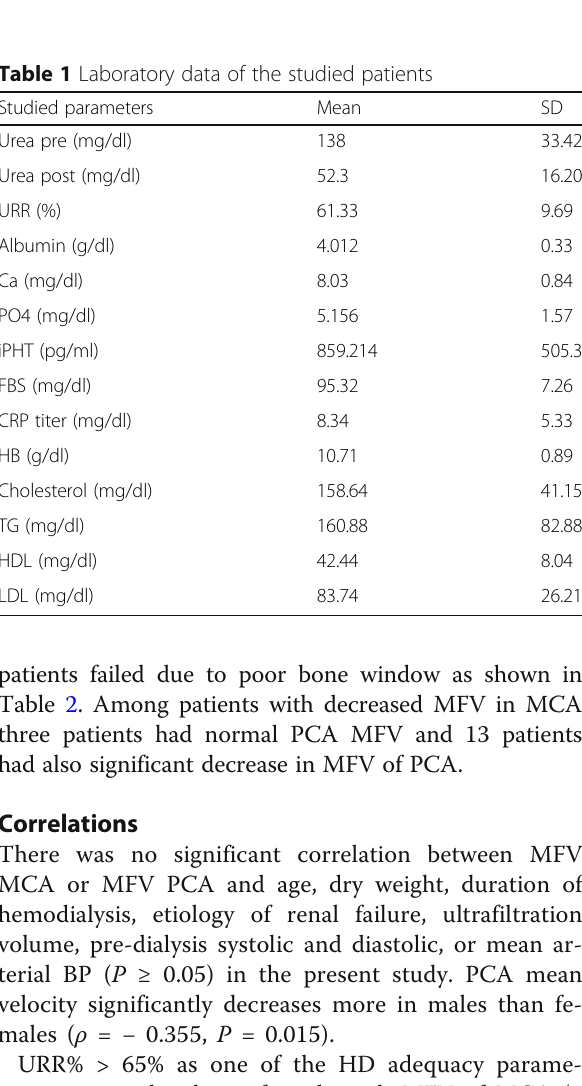
Table 1 Laboratory data of the studied patients